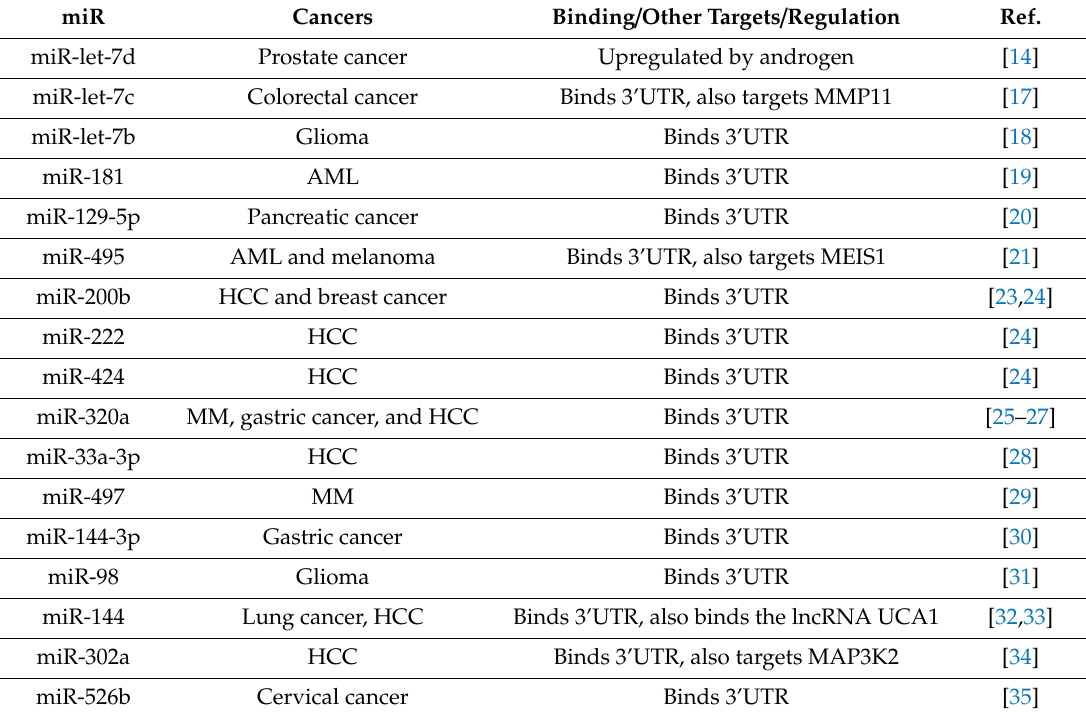
Table 1. PBX3-targetting microRNAs (miRs) in cancer. AML, acute myeloid leukemia; HCC,